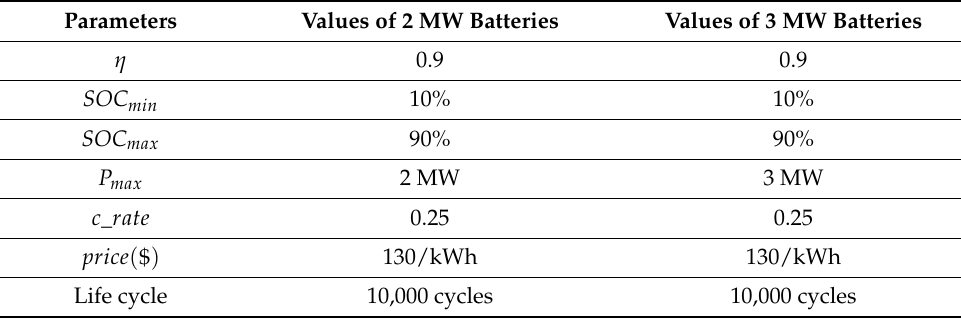
Table 8. Input parameters of two 2 MW batteries and the two 3 MW